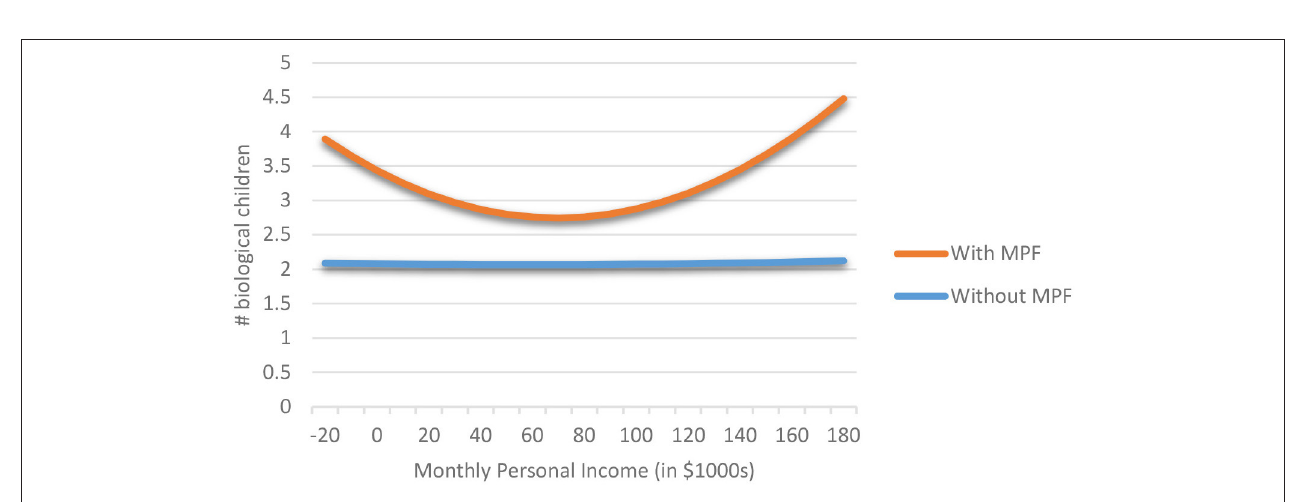
FIGURE 1 | Biological children, women with and without multipartner fertility.